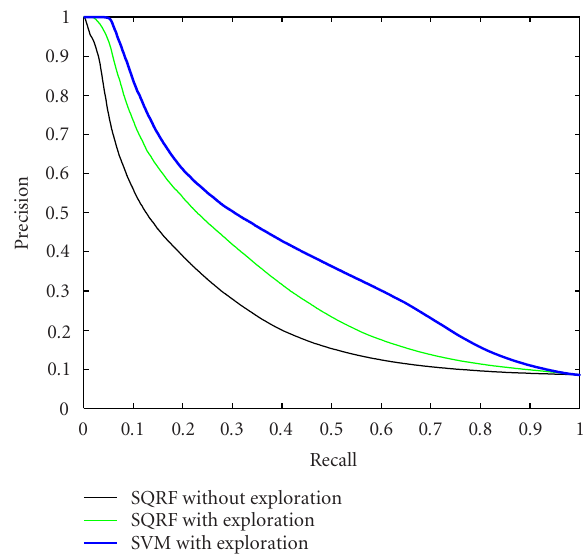
Figure 13: Precision/recall curves for semantic query relevance feedback and SVM methods with or without exploration strategy (flower category).